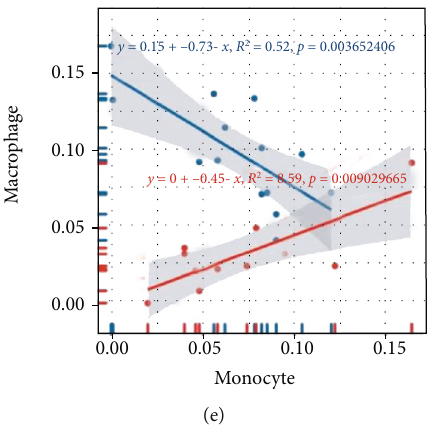
Figure 7: Immune signatures of the glomeruli in IgAN. (a) Heatmap of 24 immune cells calculated with ssGSEA in IgAN and healthy controls. (b) Boxplot of 24 immune cells in IgAN and healthy controls. Macrophages and NKT cells were signi fi cantly increased, while B cells, CD4+ T cells, Tr1, Treg, and Th1 cells were signi fi cantly decreased in IgAN. (c) Correlation heatmap of 10 main immune cells in IgAN. (d) Correlation heatmap of 10 main immune cells in healthy controls. (e) Line regression of monocytes and macrophages in IgAN and healthy controls. The proportion of monocytes and macrophages was negatively correlated in IgAN ( R 2 = 0 : 52 , P = 0 : 003 ) but negatively correlated in the control group ( R 2 = 0 : 59 , P = 0 : 009